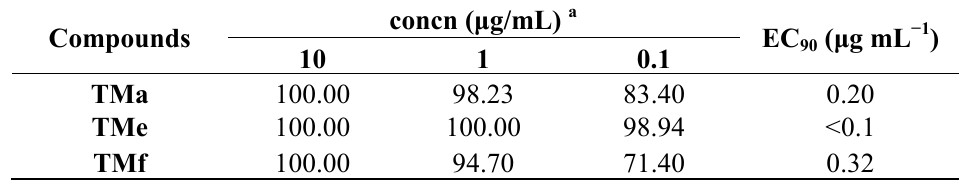
values of compounds TMa , TMe and TMf 90